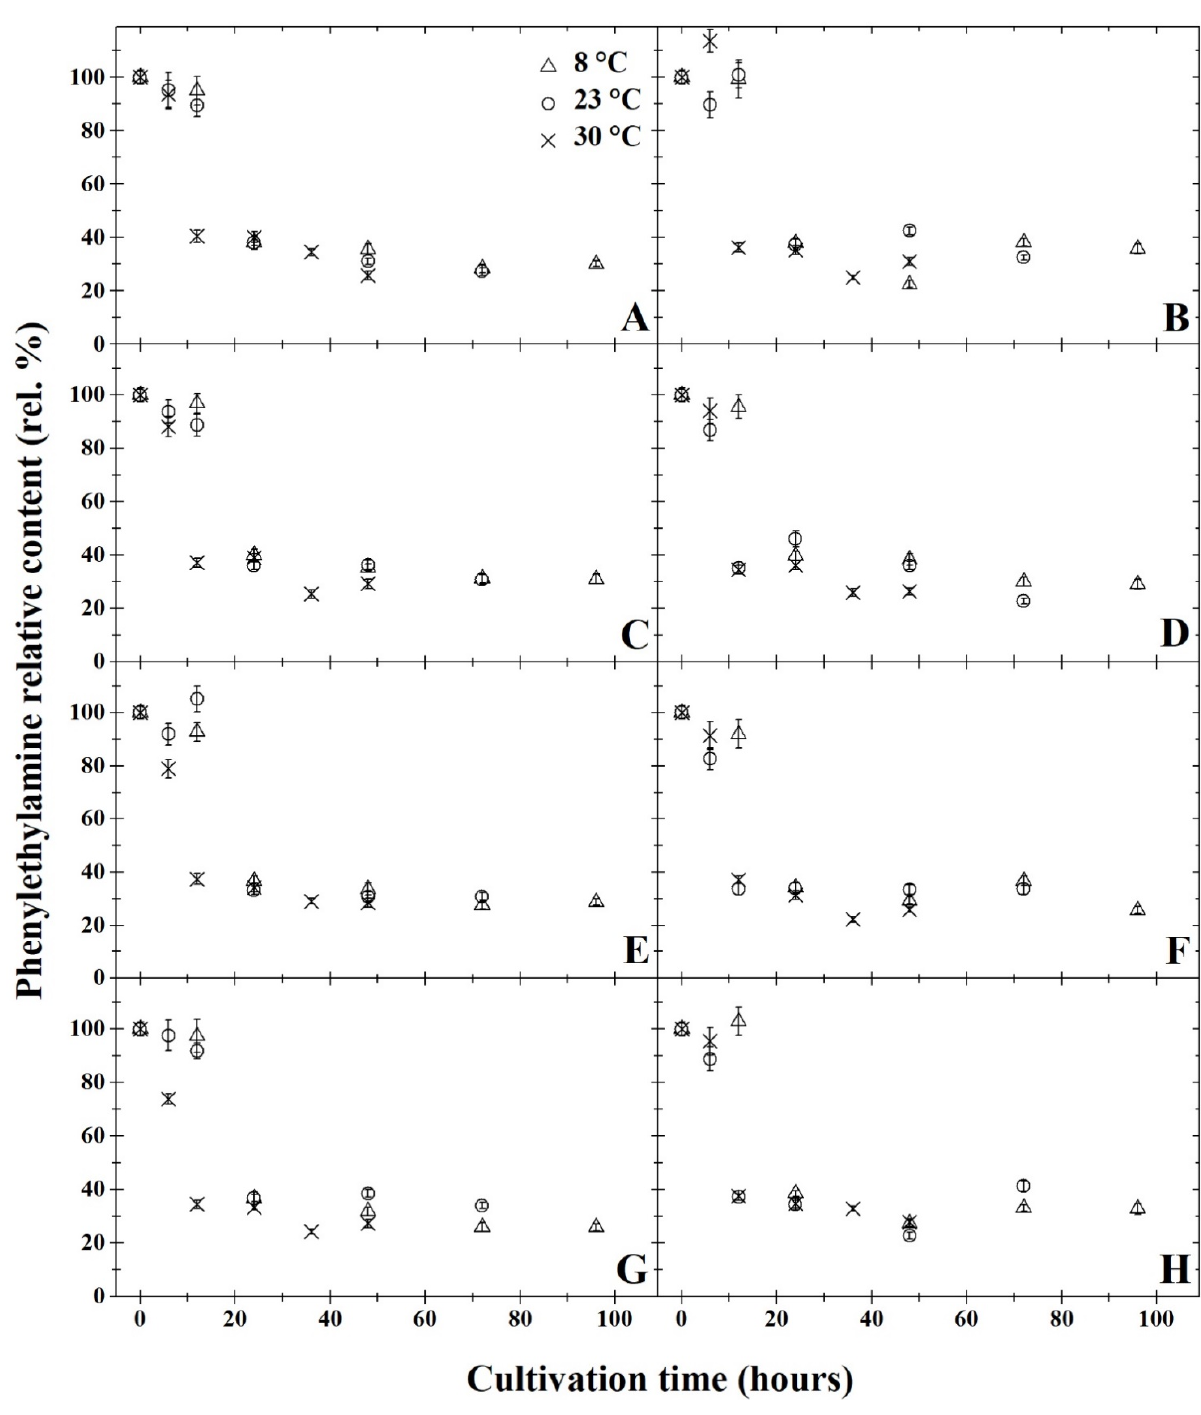
Figure 1. Development of phenylethylamine relative content (rel. %) by degradation using Bacillus subtilis DEPE IB1 in dependence on the cultivation time (hours); the initial phenylethylamine relative content at the time zero were always 100%. Parts ( A , C , E , G ) represent the results of anaerobic cultivation and parts ( B , D , F , H ) show the results of aerobic cultivation. Incubation was carried out under pH = 5 (parts A and B ), pH = 6 (parts C and D ), pH = 7 (parts E and F ), pH = 8 (parts G and H ). Three cultivation temperatures were used: 8 °C ( ), 23 °C ( ) and 30 °C ( ). The results were presented using the means and standard deviations (bars; n = 24).